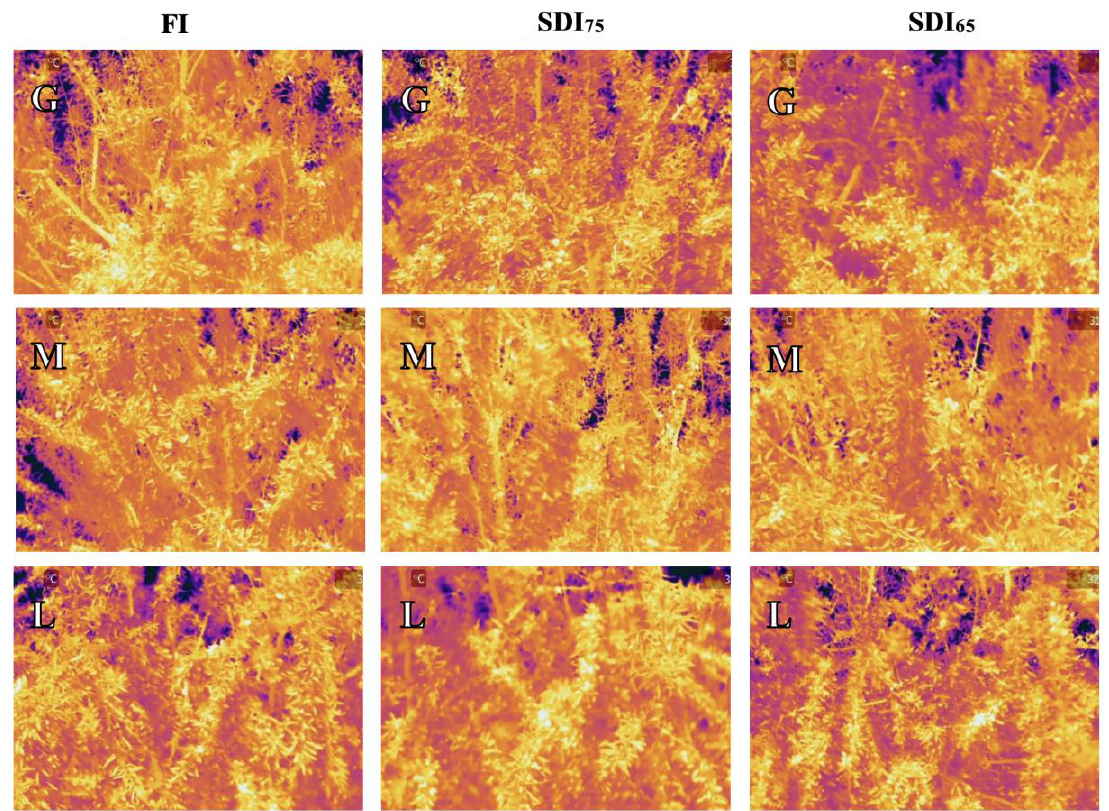
Figure 1. Thermal images at the sunny side of the studied almond canopies. FI, fully irrigated treatment; SDI 75 , sustained deficit irrigation treatment at 75% of the irrigation requirements; SDI 65 , sustained deficit irrigation treatment at 65% of the irrigation requirements; G, Guara; M, Marta; L, Lauranne.